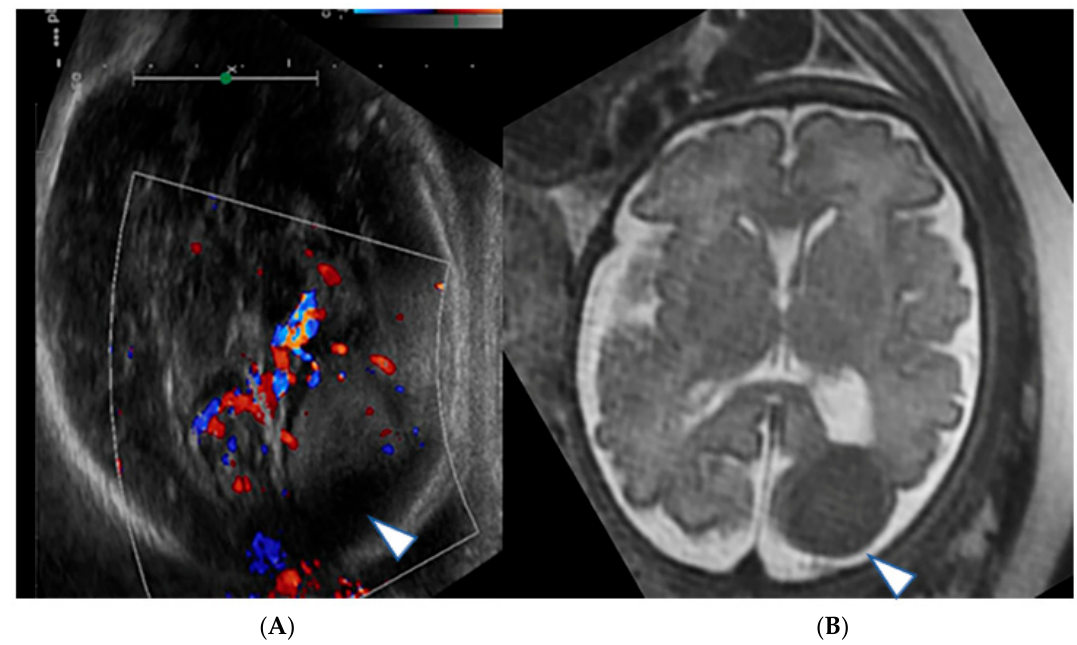
Figure 5. ( A , B ): Prenatal color coded axial US image and matching T2 ‐ weighted fetal MRI show a solid cortical/subcortical well circumscribed mass lesion within the left occipital lobe (arrowhead). The lesion exerted mild local mass effect on the left occipital horn without midline shift or hydrocephalus. On US, the lesion was mildly heterogeneously hyperechogenic and presented with an asymmetrically increased arterial flow in the left common carotid, middle cerebral and posterior cerebral arteries. There was no evidence for associated hem ‐ orrhage. Polyhydramnios was not observed. A neuroglial tumor with the differential di ‐ agnosis of cortical dysplasia was suspected. A female newborn was delivered via elective C ‐ section. MRI and computer tomography (CT) scan performed on day one of life showed a 4.7 cm × 3 mm × 3.5 cm mass lesion in the left occipital lobe with T2 ‐ hypointense suscep ‐